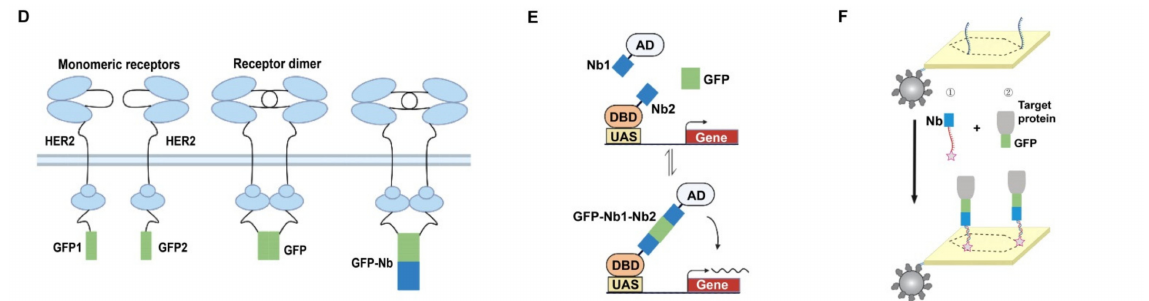
Figure 5. Applications of fluorescent protein nanobody. ( A ) Visualization of protein–protein in- teractions. Anti-GFP nanobody (Nb) bound to cell-penetrating peptides (CPPs) can penetrate the cell nucleus. If the GFP-tagged protein does not interact with the RFP-tagged protein, only the GFP-tagged protein re-localizes to the nucleolus via Nb-CPP, showing green color. However, if the two proteins interact, both proteins re-localize to the nucleolus, showing yellow color. ( B ) GFP nanobody enables the selective labeling of newly exocytosed vesicle proteins. Step 1: The vesicle protein is coupled to GFP and incubated with a non-fluorescent nanobody (NbGFP), resulting in the inaccessibility of GFP with the fluorescence-binding nanobody (NbGFP*). Step 2 and 3: After stimulation of cellular exocytosis, the new vesicle protein is exposed to the plasma membrane and can be labeled by NbGFP*. ( C ) Schematic illustration of deGradFP. Protein selective degradation is accomplished through the ubiquitin pathway, which is carried out by a complex series of enzymes. The F-box protein (FBP) in the SKP1-CUL1-F-box protein ligase complexes (SCFs) is fused to the anti-GFP nanobody (Nb) to recognize the GFP fusion protein, and the ubiquitin-conjugating enzyme (E2) covalently links multiple ubiquitin molecules to the target protein. Subsequently, the polyubiqui- tinated protein is degraded by the proteasome. ( D ) Schematic description of BiCAP. HER protein is fused to N-terminal (GFP1) or C-terminal (GFP2) fragments of GFP. When the two fusions form a dimer, GFP refolds and fluoresces. The HER dimer and its interacting proteins are then enriched using a GFP nanobody, which has no binding ability toward the GFP fragments and, thus, enables the isolation of the dimer. ( E ) GFP-dependent transcription system. The DNA-binding domain (DBD) and the activation domain (AD) are fused with GFP nanobody 1 (Nb1) and GFP nanobody 2 (Nb2), respectively. In the presence of GFP, DBD-Nb1 and AD-Nb2 can activate the upstream activating sequence (UAS) reporter gene, which leads to the upregulation of target genes. ( F ) Recognition of GFP-labeled proteins on DNA nanostructures. The DNA nanostructures with two binding sites are ligated onto the magnetic resin, bound with GFP nanobody (Nb) by complementary base pairing, and then incubated with GFP-labeled proteins. Hence, GFP-labeled proteins can be accurately attached to the